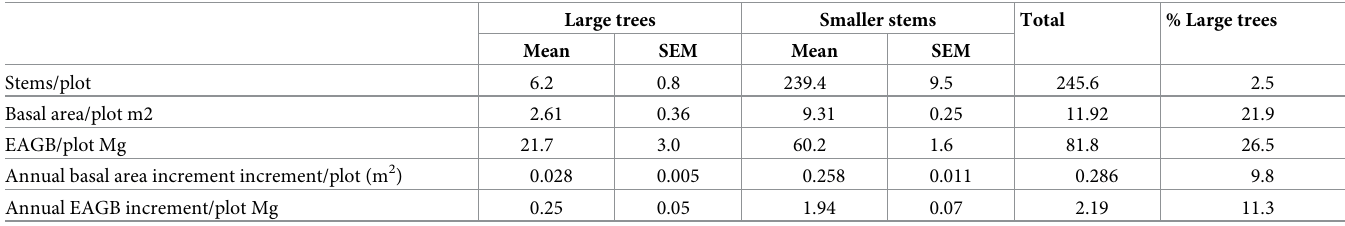
Table 1. Stem abundance and productivity.